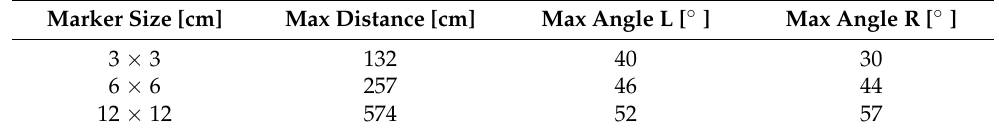
Table 2. Measurement results at 63.7 klx light intensity.